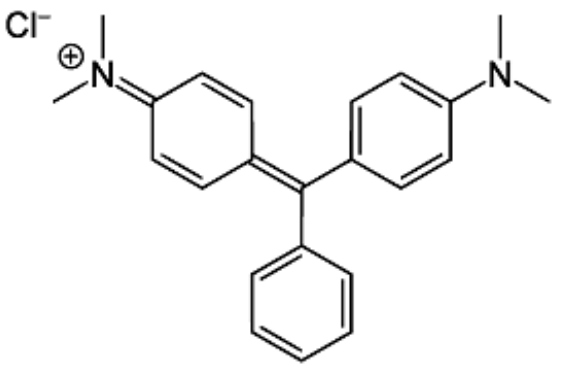
Figure 1. Chemical structure of MG dye.